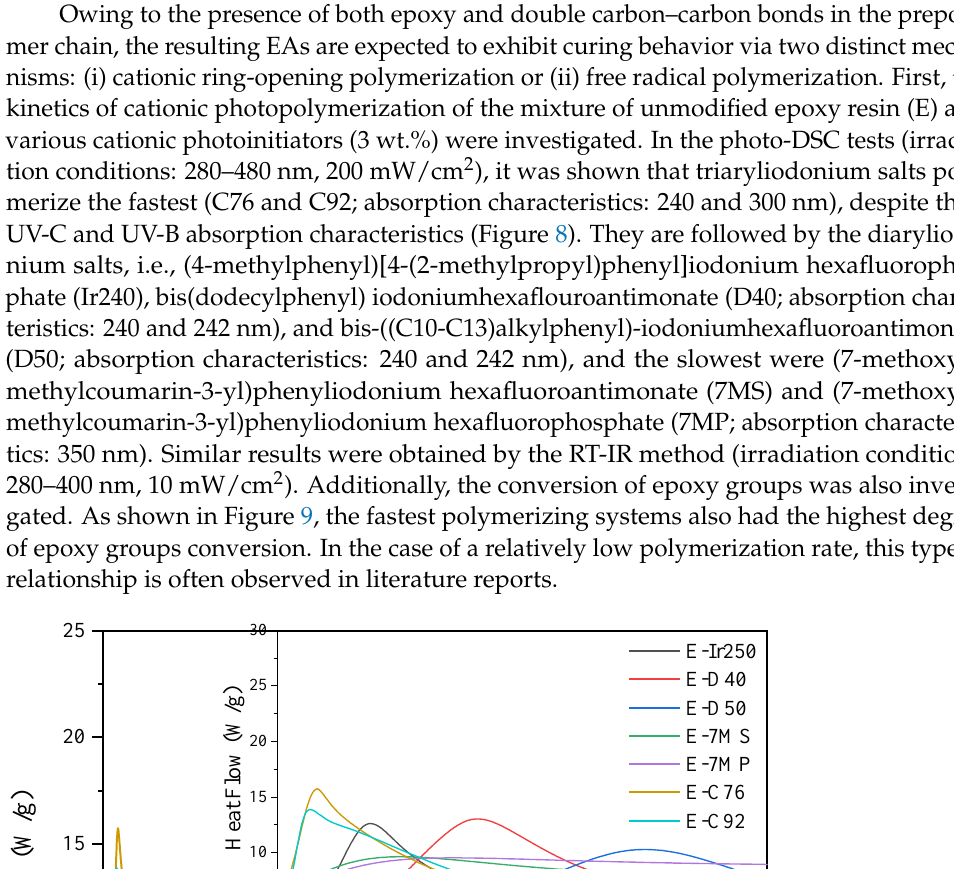
Figure 9. The epoxide conversion and photopolymerization rate curves of the epoxide resin formu- lations with cationic photoinitiators. Further, the research on systems from the synthesized hybrid epoxy acrylate resin is presented. It is worth emphasizing that owing to the presence of both epoxy and double